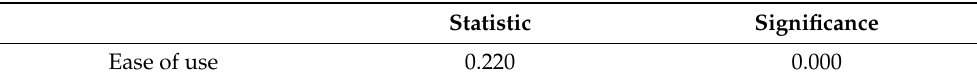
Table 13. Normality